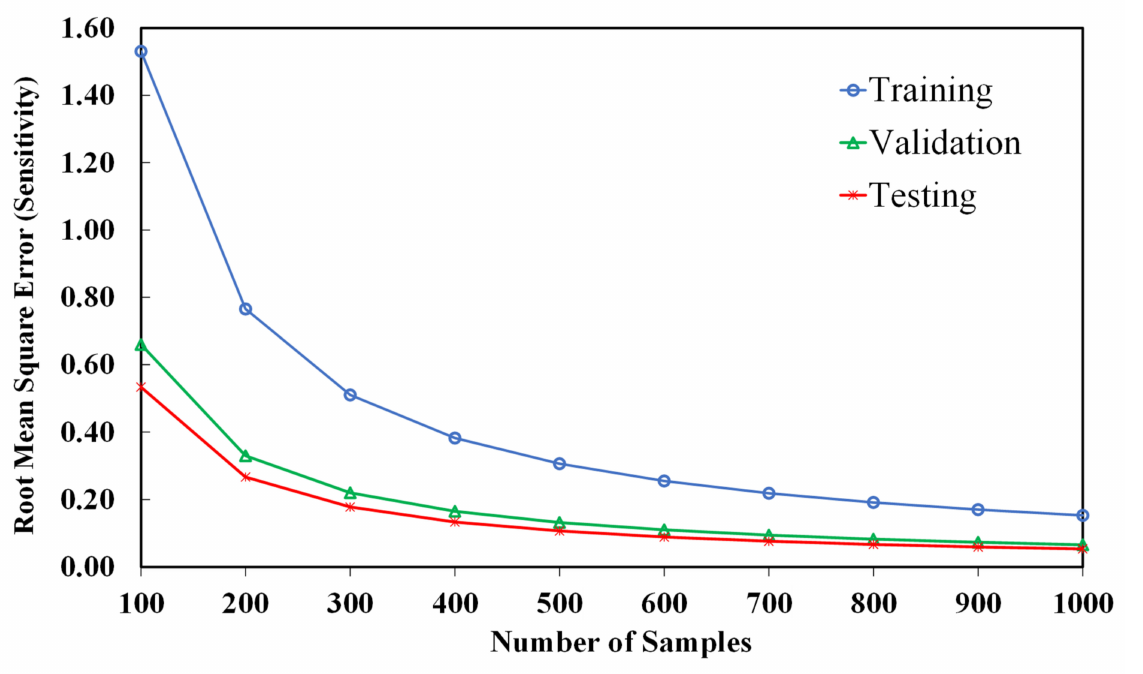
Figure 6. The effect of the number of samples on the RMSE of training, validation, and test